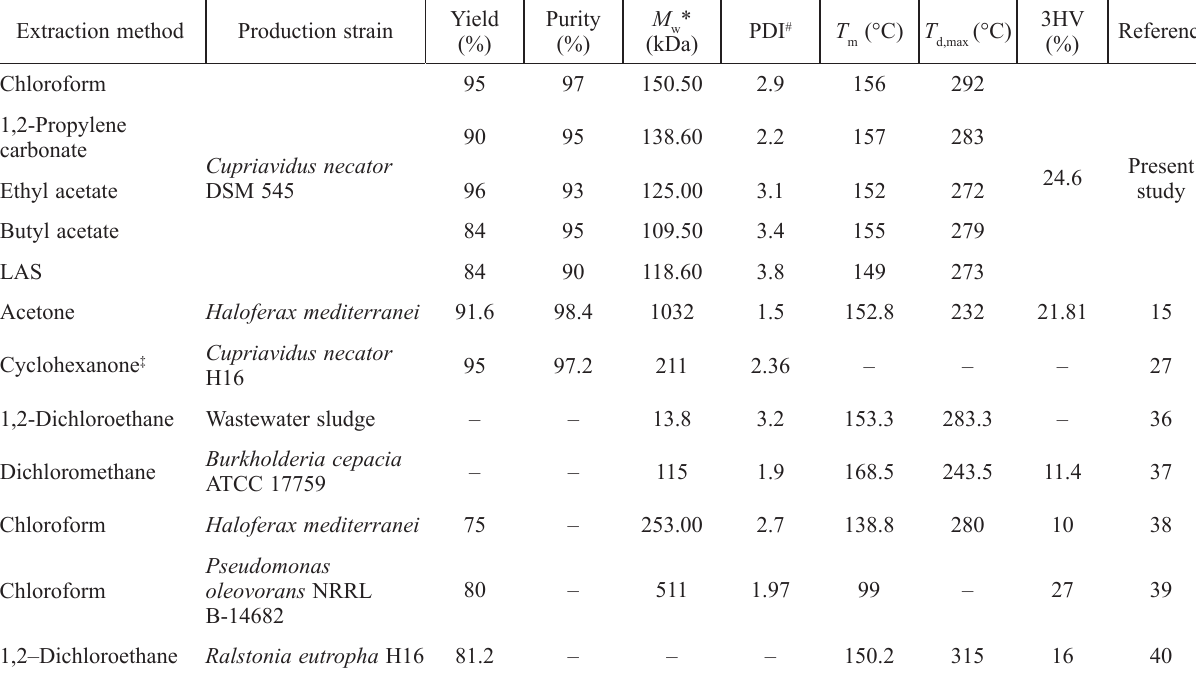
Table 1 – Physical and thermal properties of poly(3HB-co-3HV) using different extraction methods and its comparison with litera- ture reports Extraction